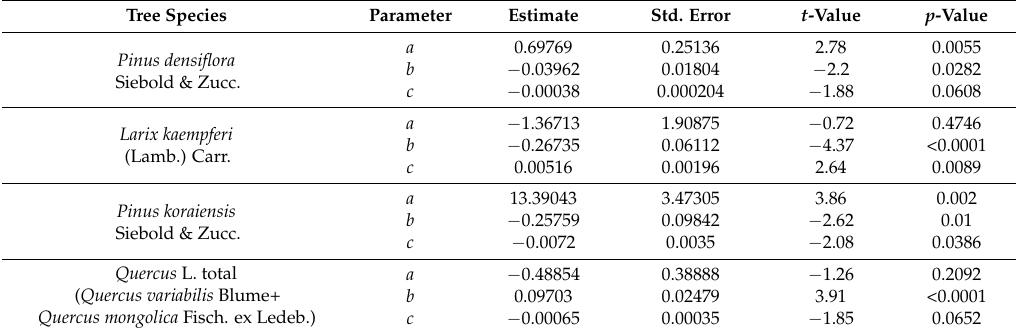
Table 5. Estimated parameters and associated standard errors for Equation (4) by using residuals and climate factors for each tree species.